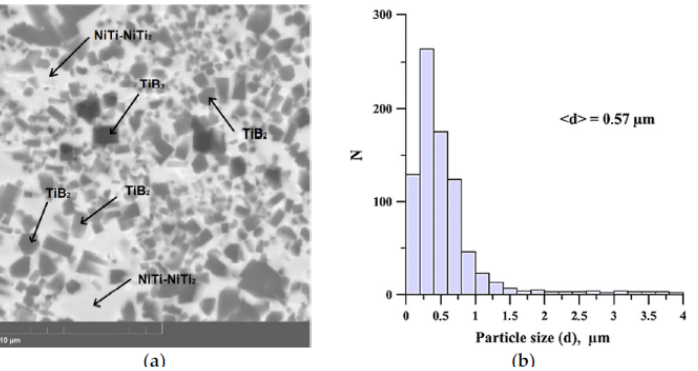
Figure 7. ( a ) SEM image of a local area of a composite SHS powder particle, and ( b ) titanium diboride particle distribution by